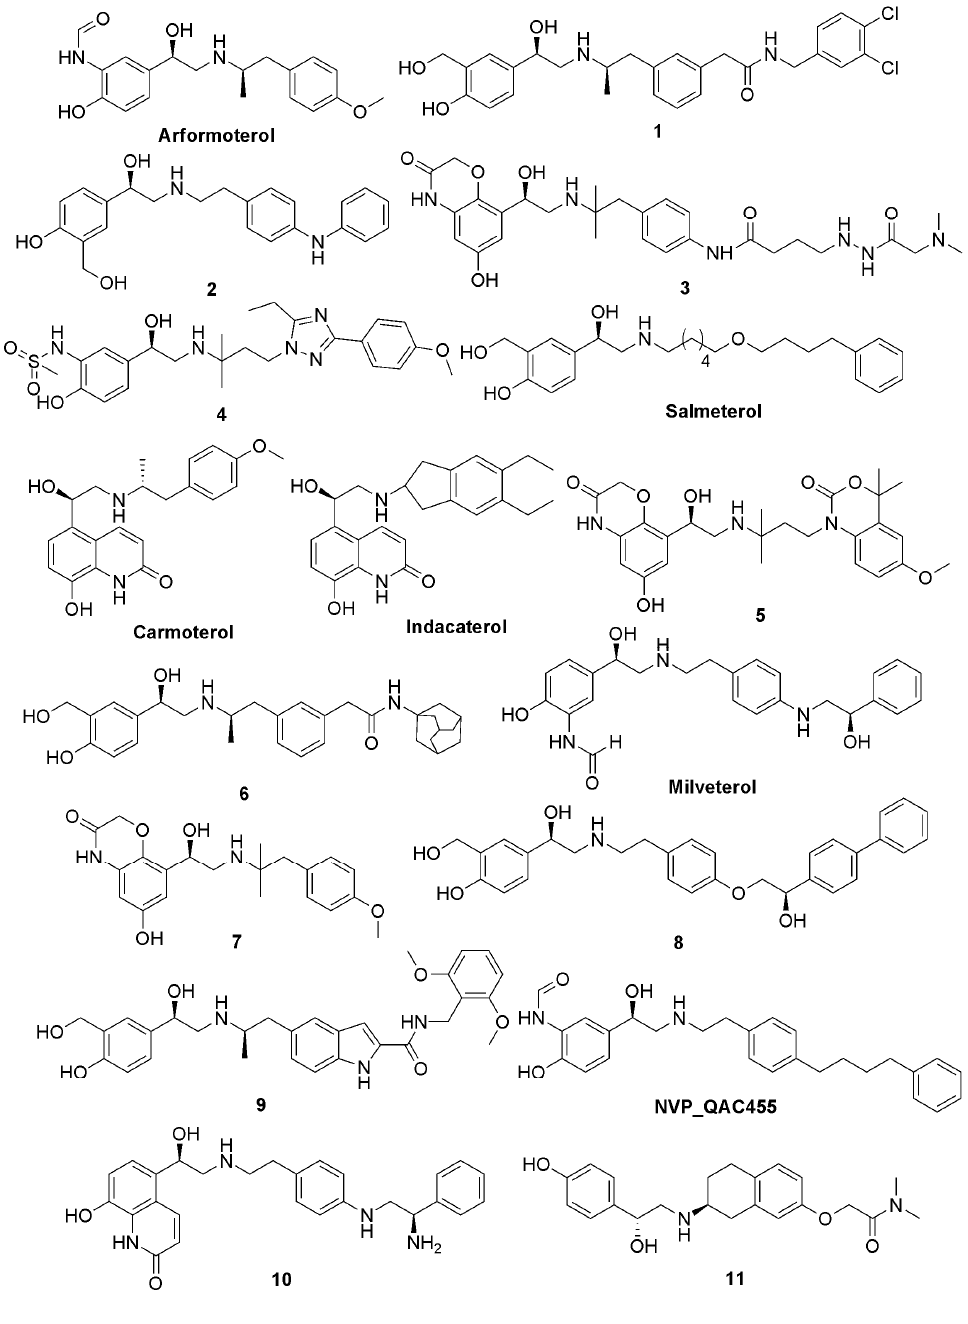
Figure 1. Chemical structures of the selective β pharmacophore